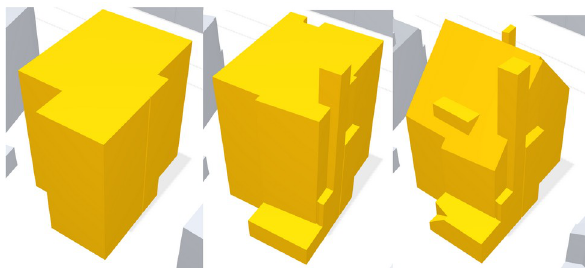
Figure 1 . Excerpts of the reconstructed dataset at three LoDs. From left to right: LoD1.2, LoD1.3,